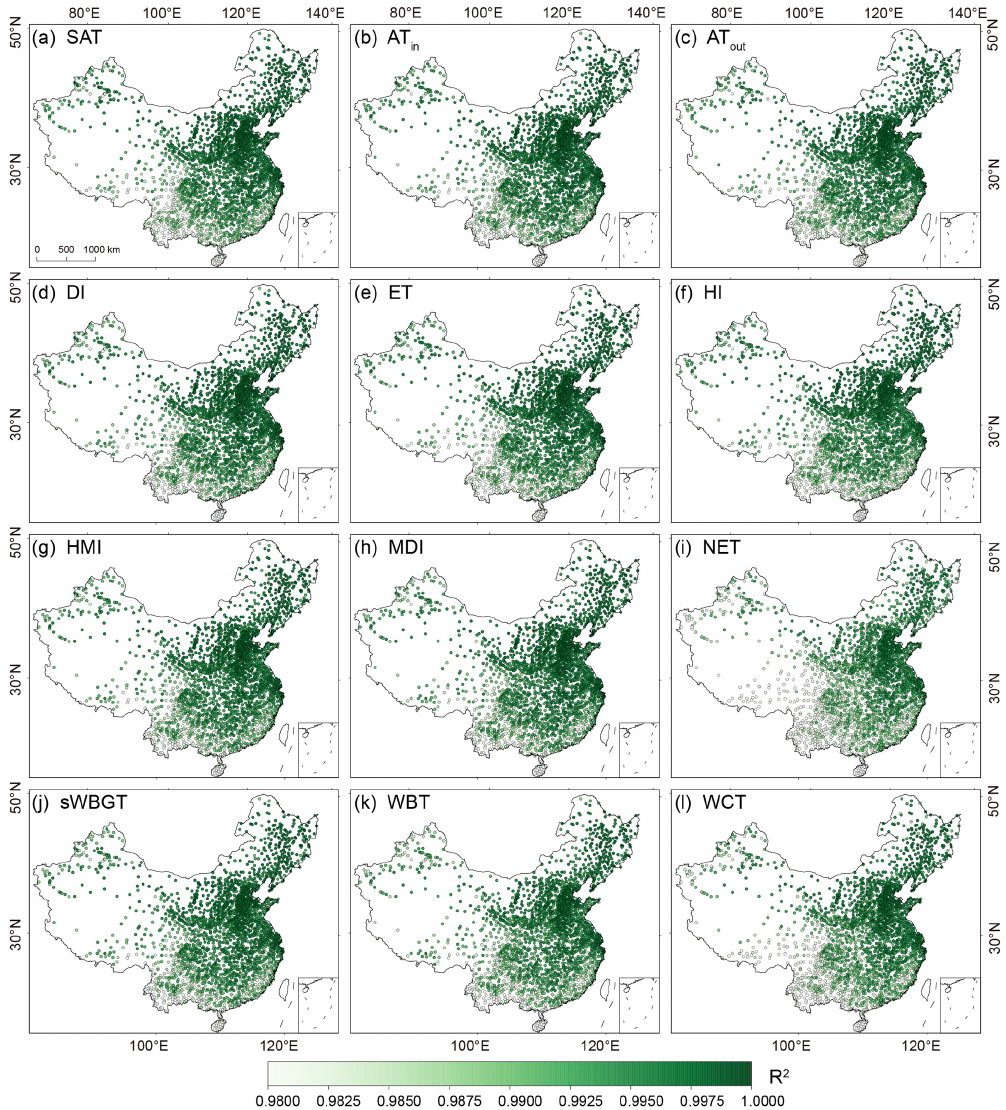
Figure 4. Spatial distribution of R 2 of the 12 human thermal index predictions at individual meteorological stations over the mainland of China during